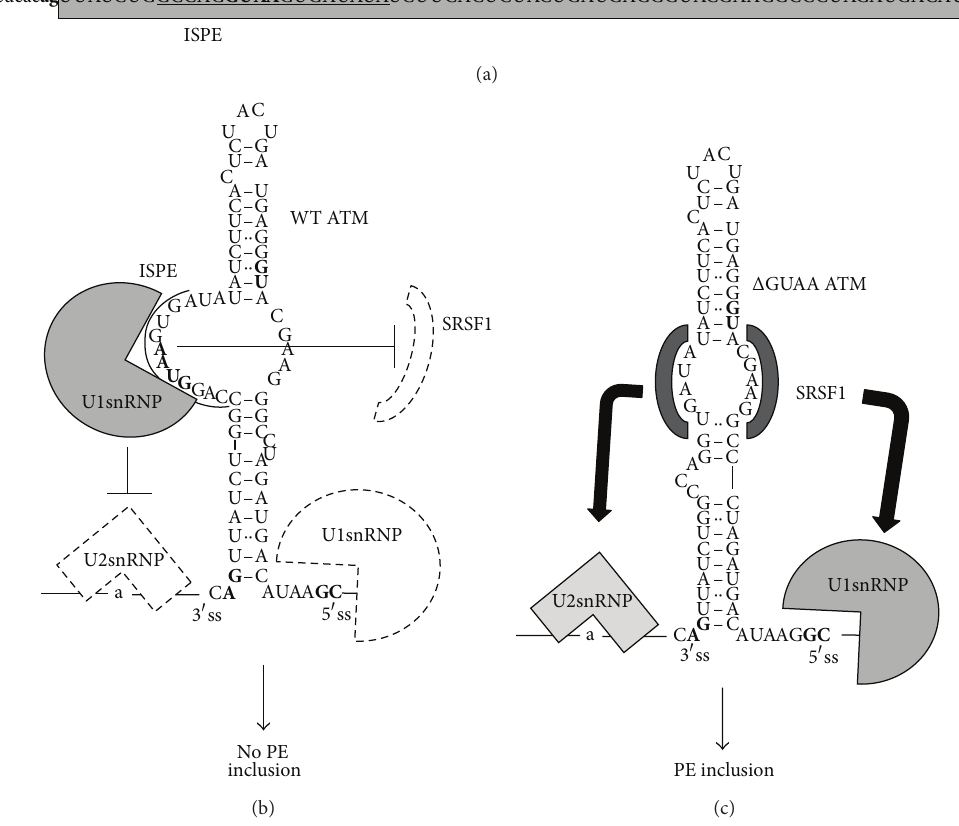
Figure 1: ATM pseudoexon activated in cancer. (a) Scheme of the ATM pseudoexon insertion caused by a 4nt deletion (GUAA) occurring 1873 nt downstream from the donor splice site of ATM exon 20. The solid lines indicate introns. Dotted lines include the 65nt-ATM pseudoexon (gray box). The intron-splicing processing element (ISPE) complementary to U1 snRNA, the RNA component of the U1 small nuclear ribonucleoprotein (snRNP), is underlined. (b) Schematic model of U1snRNP mediated inhibition of pseudoexon insertion in normal conditions. In this model, U1snRNP binding to the ISPE blocks pseudoexon inclusion by inhibiting recruitment of U2snRNP to the 3 󸀠 splice site region and SRSF1 binding to the stem loop of the pseudoexon (shown as dotted lines). (c) In the case of the disease associated ATM Δ GUAA deletion, the internal U1snRNP binding site is no longer present due to the deletion of the ISPE. This leads to a more efficient binding of SRSF1 to the enhancer site and stabilization of the U2snRNP interaction with the branch site and U1snRNP with the 5 󸀠 gc donor